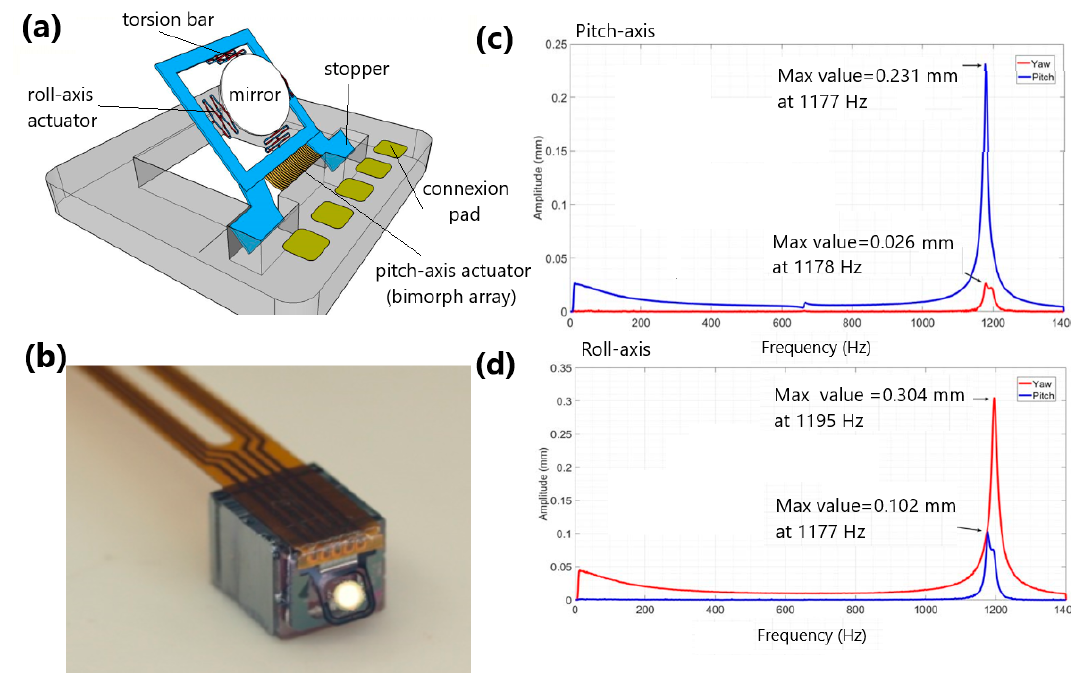
Figure 21. Electrothermal mirror: ( a ) schematic and ( b ) microphotograph of a MEMS scanner assembled on top of a Mirau interferometer. The frequency response for inner pitch axis ( c ) and roll-axis ( d ).